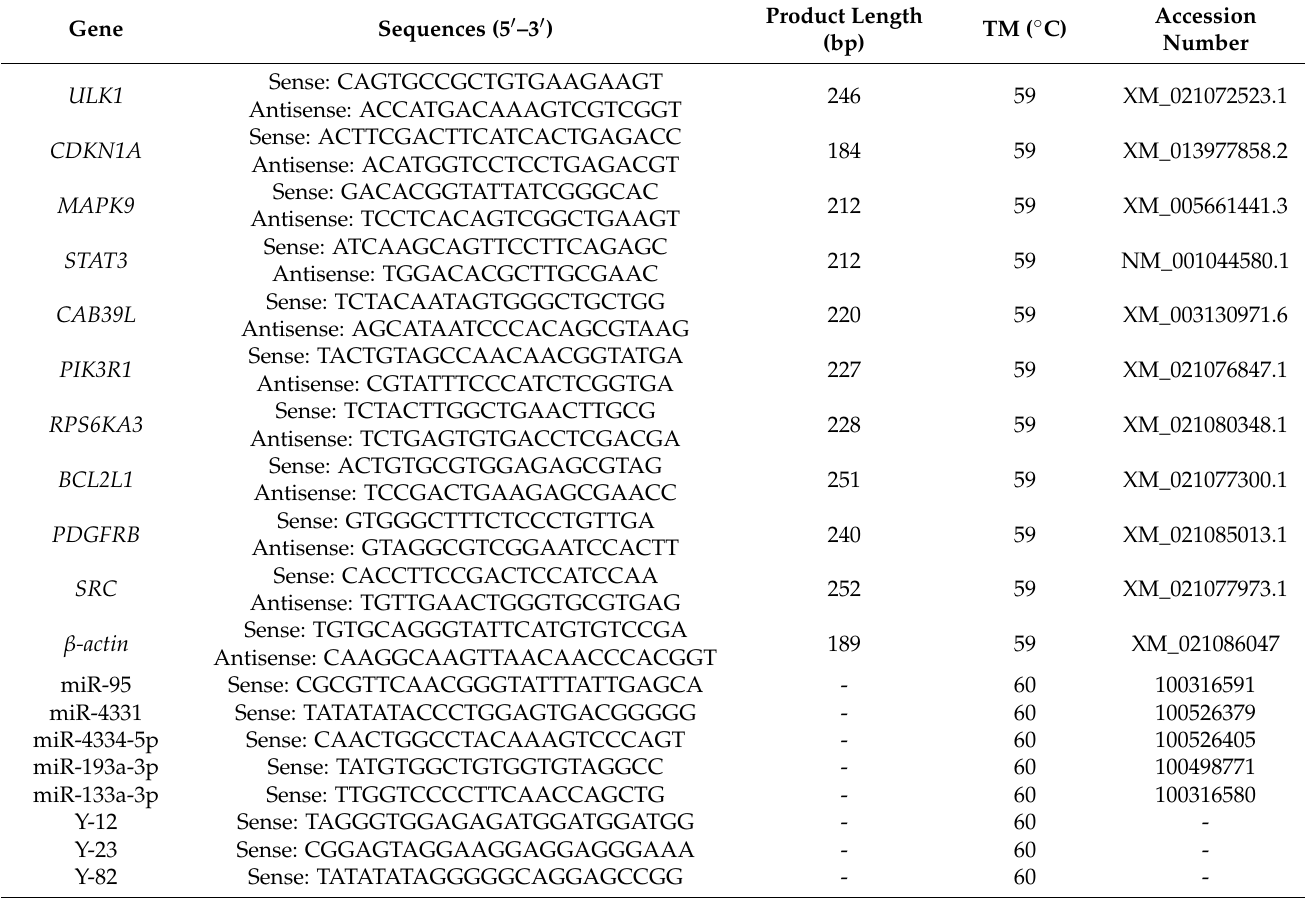
Table 2. Primer pairs used for qRT-PCR